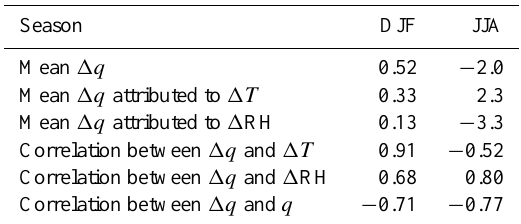
Figure 12. Temporal derivative (black line) of (a) humidity and (b) δD at the surface simulated by LMDZ. This temporal derivative can be decomposed into the tendencies from different processes (illustrated in Fig. 11): horizontal advection (red); deep convection (green); large-scale condensation and re-evaporation (blue); surface evaporation and boundary-layer dynamics (cyan). We used a 5-day filter to focus on seasonal and synoptic variations. Table 7. Model–data difference in near-surface air specific humidity ingkg − 1 and its different contributions associated with temperature ( T ) or with relative humidity (RH). The 1 sign refers to the model– data